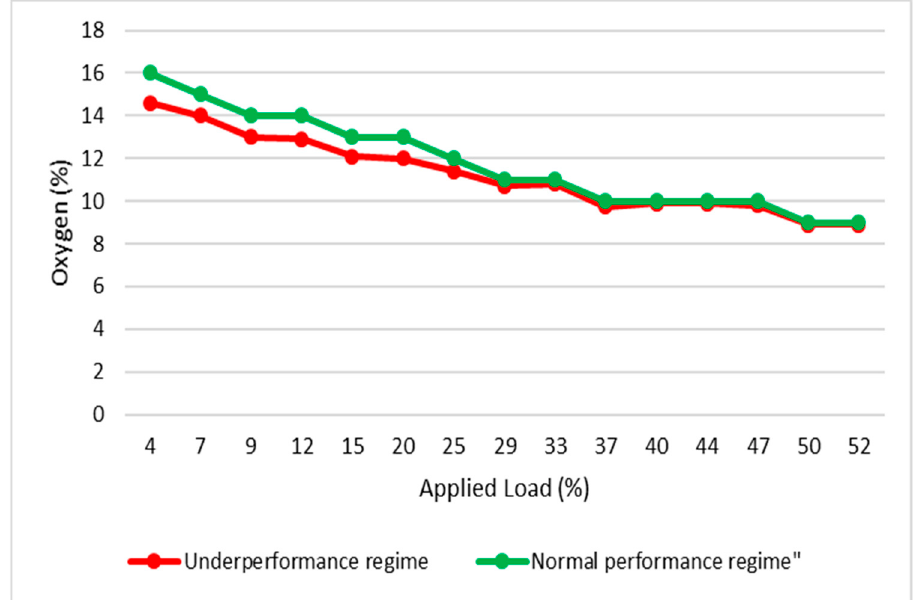
Figure 9. Variation of the O 2 rate according to the applied loads.